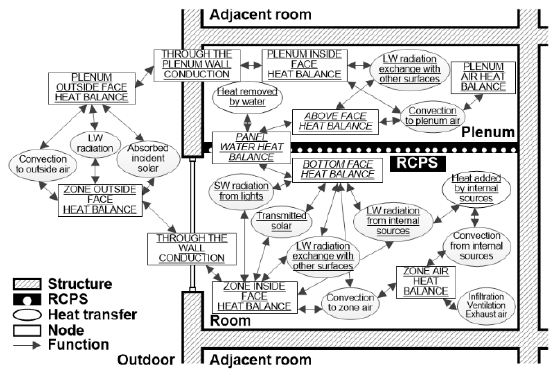
Figure 3. Heat transfer in a space equipped with CRCP.